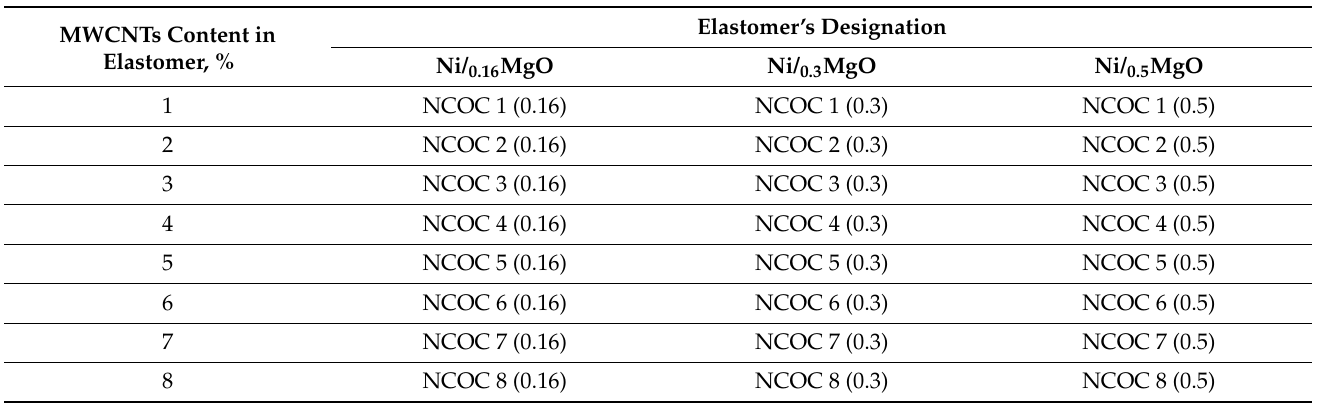
Table 2. Elastomers modified with MWCNT.